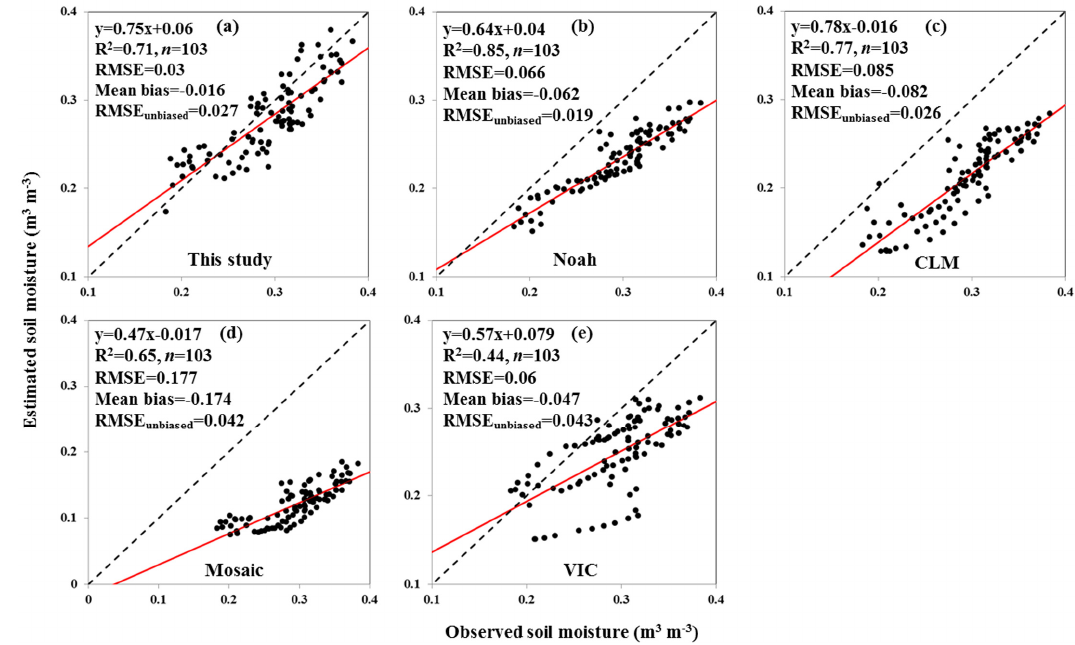
Figure 10. Comparison of daily area-averaged surface soil moisture estimated from the trapezoidal method and four land surface models against soil moisture